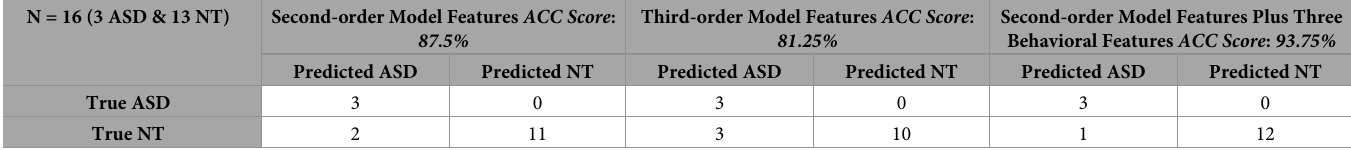
Table 6. Classification confusion matrices. N = 16 (3 ASD & 13 NT) Second-order Model Features ACC Score :